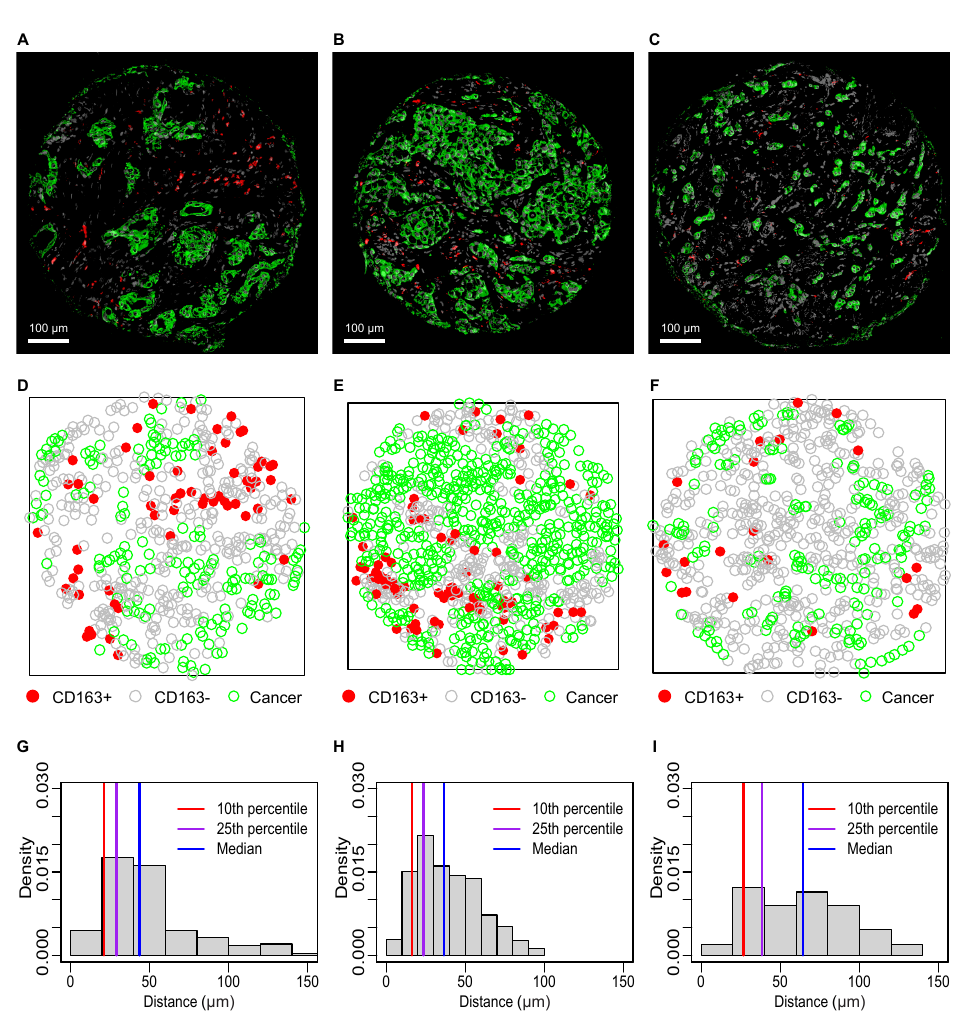
Figure 2. Spatial analysis of CD163 + TAMs and cancer cells in breast cancer. IF-IHC images (( A – C ); cancer cells green, CD163 + TAMs red) with corresponding marked point patterns ( D – F ) of CD163 + TAMs (red), CD 163 − cells (grey), and cancer cells (green), and nearest neighbor distance (NND) distributions ( G – I ) for cancer cells to the nearest CD163 +